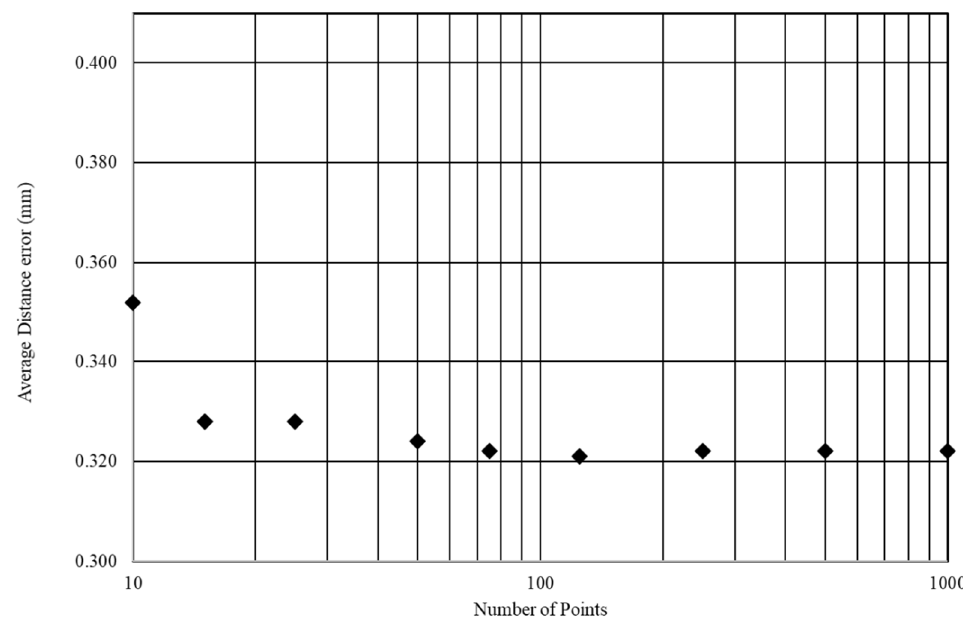
Figure 12. Average distance error between 10 and 1000 control points based on real CMM measurements for a part with defect.